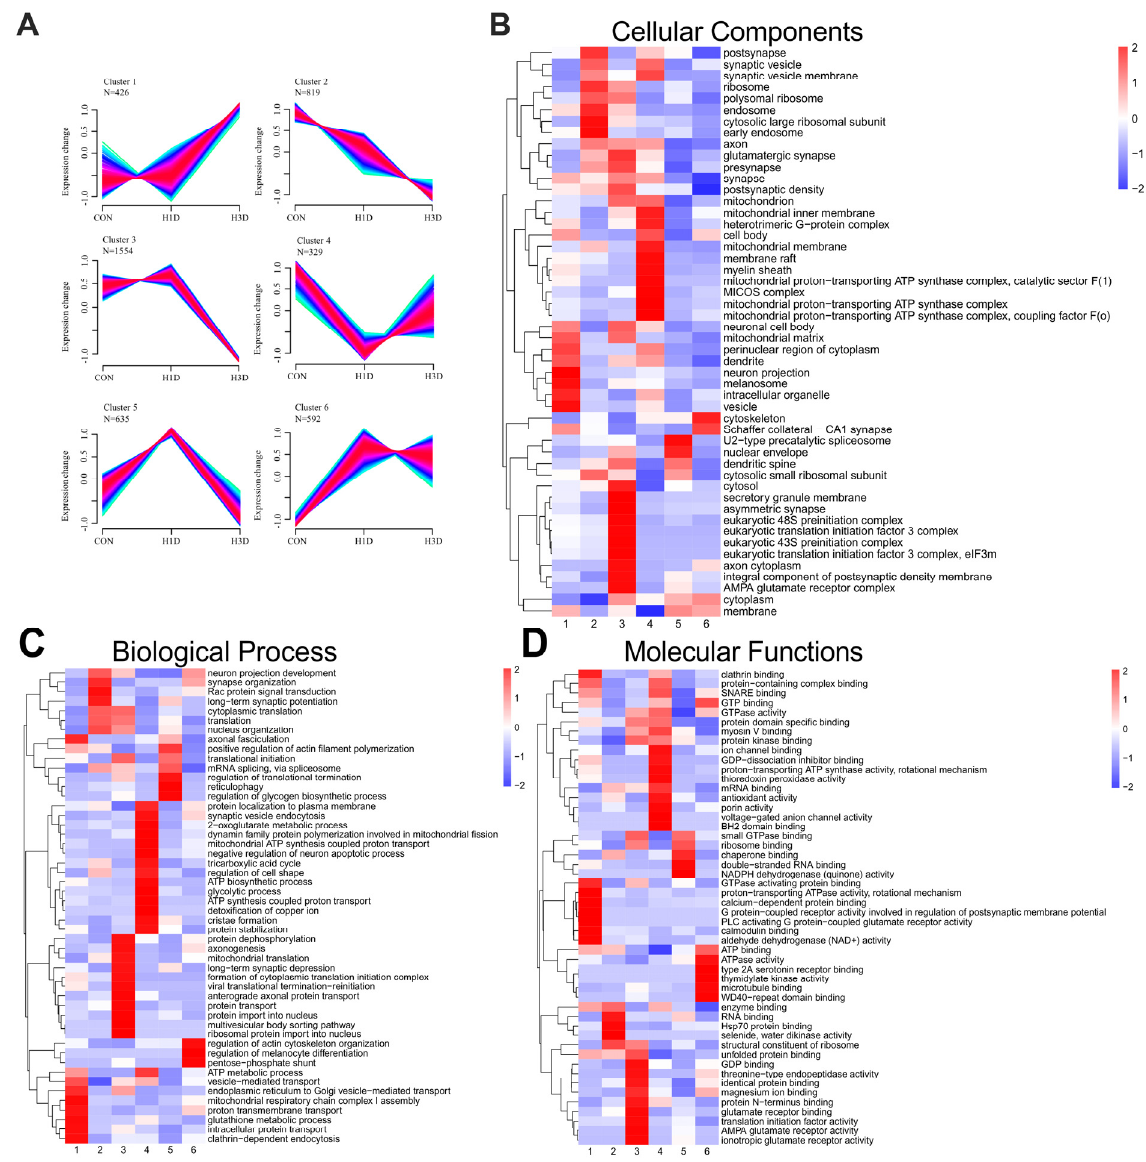
Figure 3. Temporal analysis of hippocampal proteome dynamic alterations induced by hypoxic stress. ( A ) Unsupervised clustering of proteome dynamics revealed six clusters with distinct protein expression profiles: n represents the number of proteins per cluster. The color represents memberships. The red represents more memberships, the blue and green low memberships. ( B – D ) GO enrichment analysis of each cluster was performed using Fisher’s exact test ( p < 0.05). Biological processes (BP) ( B ), molecular functions (MF) ( C ), and cellular components (CC) ( D ) of the clusters are visualized.